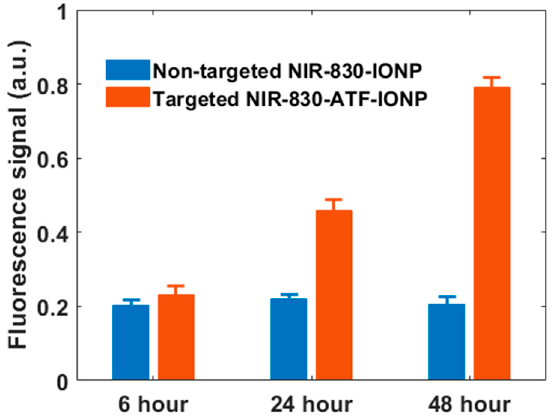
Figure 5. Quantitative plot of FMT recovered mean fluorescence signals from the two animal groups at 6, 24, and 48 h following the injection of nontargeted NIR 830-IONP (blue) and targeted NIR 830-ATF-IONP (orange).